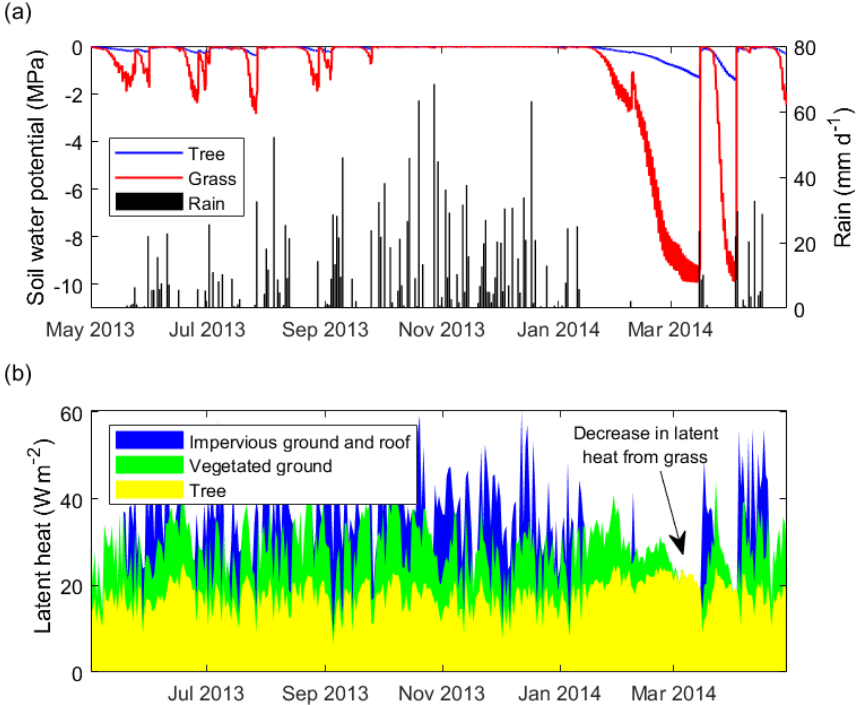
Figure 9. (a) Rain in mmd − 1 (measurement) and soil water potential averaged over the root zone (MPa) (simulation) showing the water stress experienced by the ground vegetation (grass) and trees during the model validation in Telok Kurau, Singapore. In the current parameterization, plant stomatal closure starts at a soil water potential of − 0 . 5 and − 0 . 9MPa for grass and trees, respectively. Stomatal closure reaches 50% at − 1 . 6 and − 1 . 7MPa for grass and trees, respectively. (b) Simulated time series of latent heat from impervious surfaces, vegetated ground, and trees during the model validation period in Telok Kurau, Singapore. The shown fluxes correspond to the additive flux contribution from each surface to the total canyon latent heat flux. Table 4. Mean change over the whole simulation period and maximum change simulated within the mean daily cycle in local time (LT) of 2m air temperature ( (cid:49)T 2m ), 2m relative humidity ( (cid:49) RH 2m ), and evapotranspiration fluxes ( (cid:49) ET canyon ) at λ G,veg = 100% compared to λ G,veg = 0%, LAI = 5 compared to LAI = 0.5, and V c,max = 120µmolCO 2 s − 1 m − 2 compared to V c,max = 20µmolCO 2 s − 1 m − 2 . The hour of the day experiencing the maximum change is reported. Mean